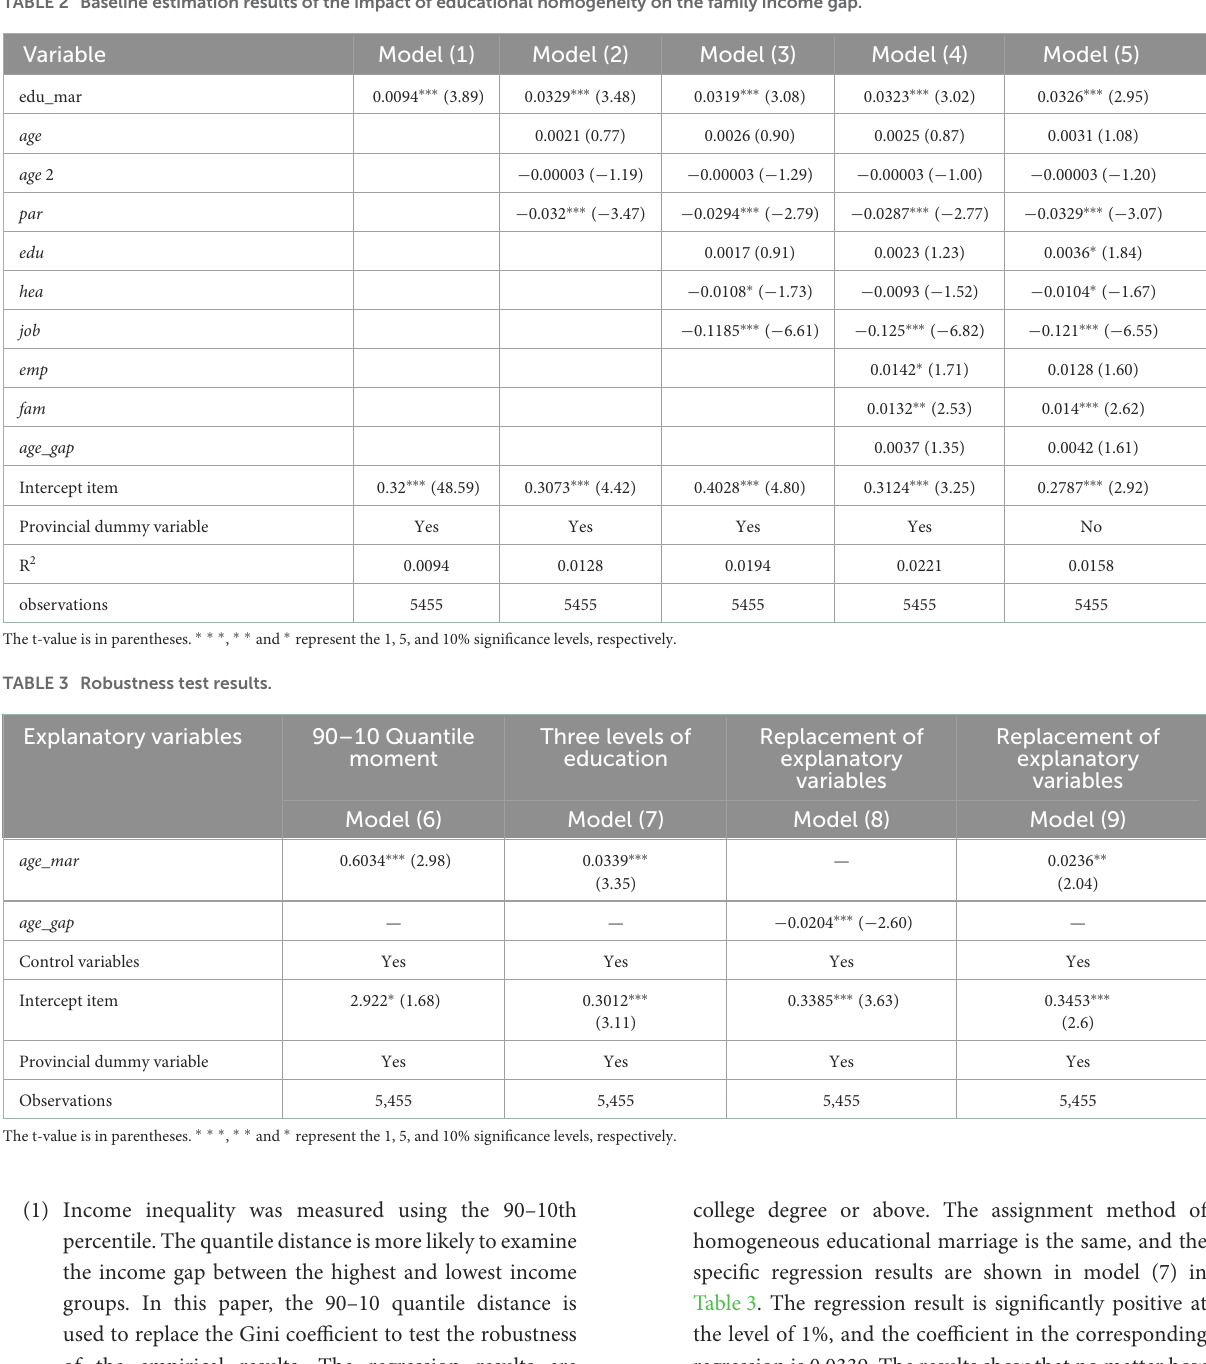
TABLE 2 Baseline estimation results of the impact of educational homogeneity on the family income gap.